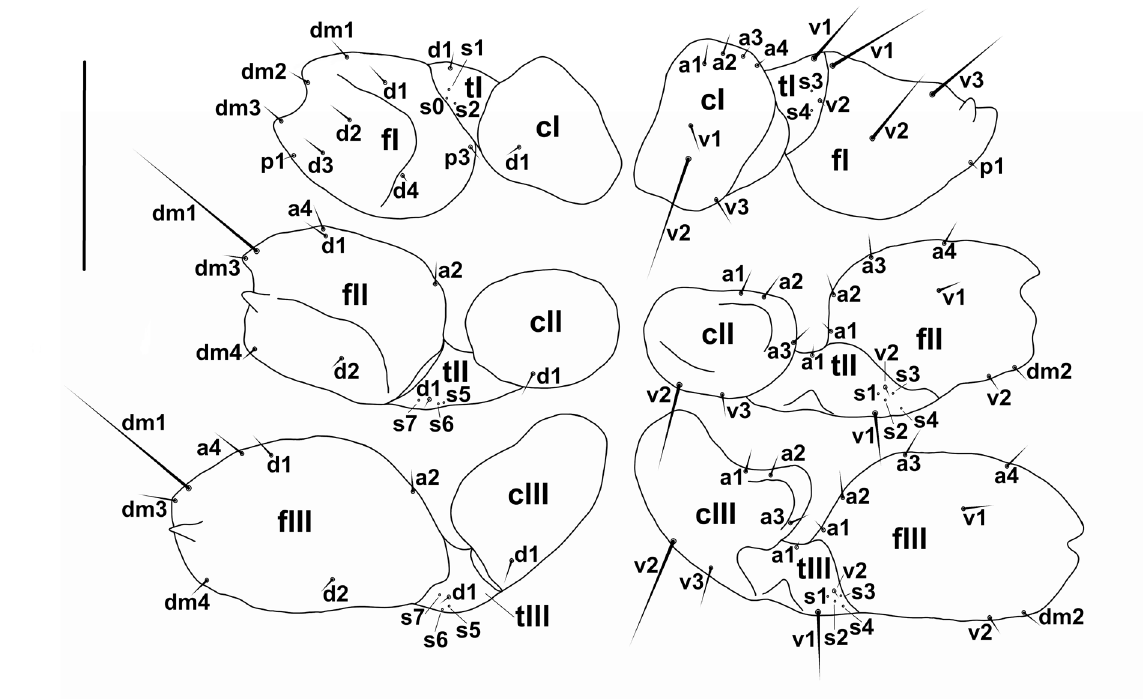
Fig. 5. Philopterus acrocephalus Carriker, 1949 ex Acrocephalus melanopogon (SK25 in MMBC): nomenclature of male leg chaetotaxy, dorsal and ventral views. Abbreviations: c – coxa; t –